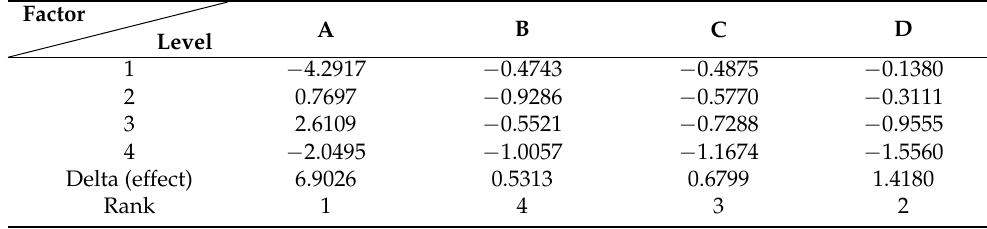
Table 5. Mean responses for S/N ratios for each